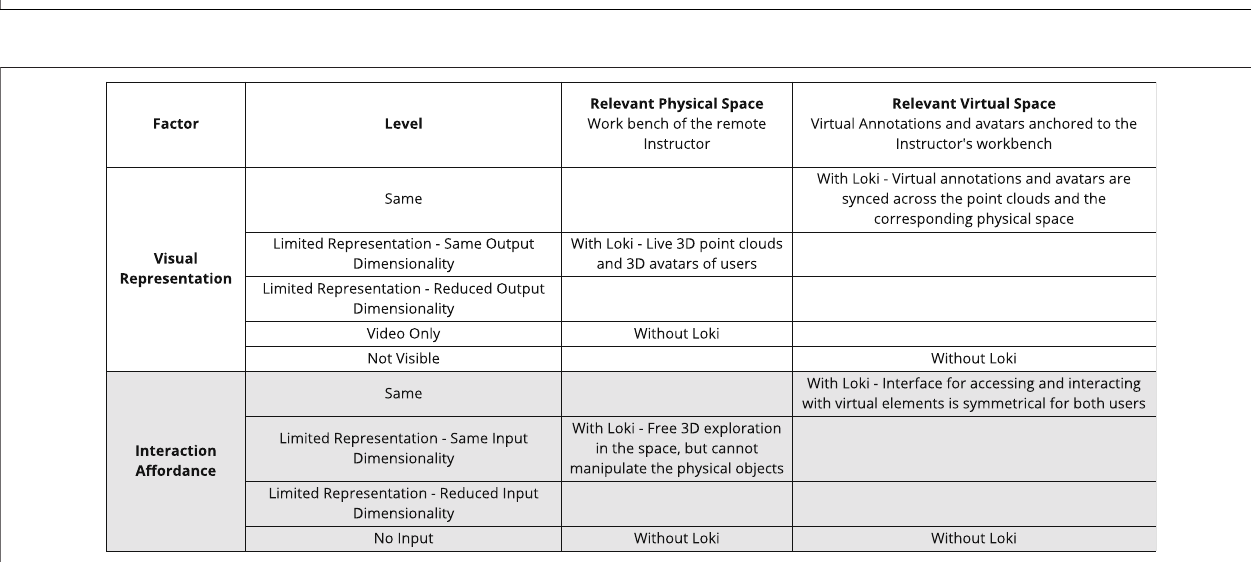
FIGURE 17 | Role of Interactive Mixed Dimensional Media in facilitating Mixed Reality telepresence for instruction of physical tasks.